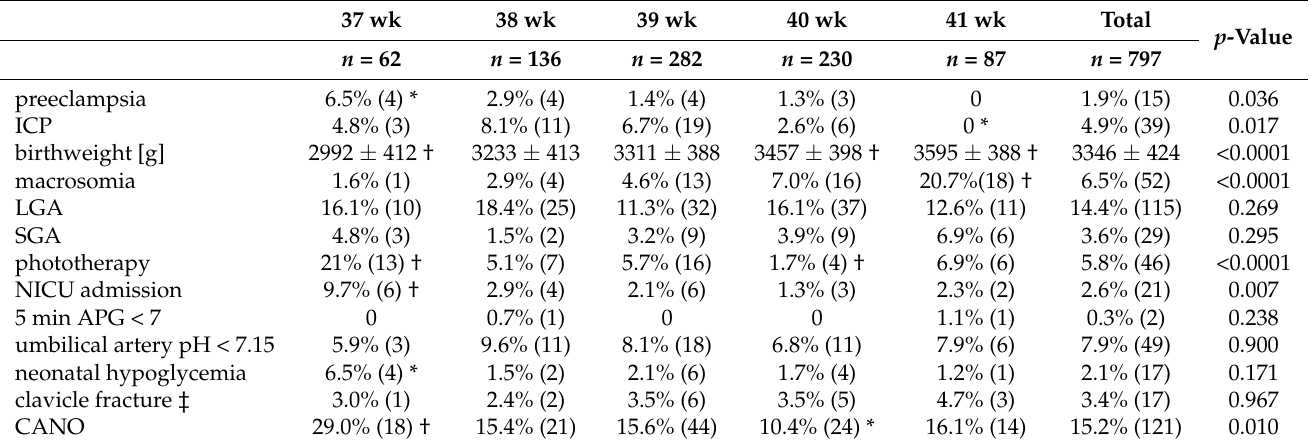
Table 3. Perinatal and neonatal outcomes stratified by gestational age.